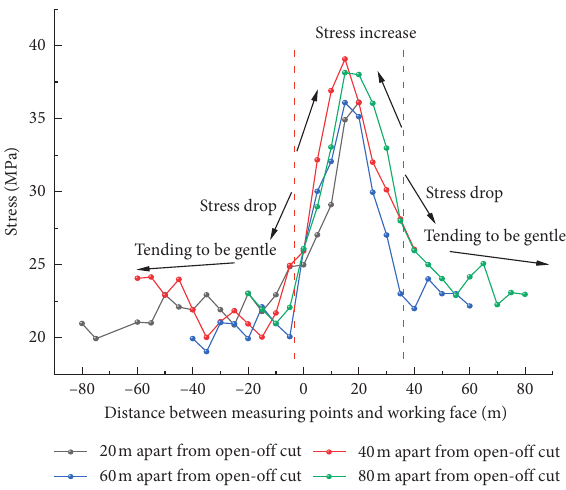
Figure 10: Stress curve of the roadway